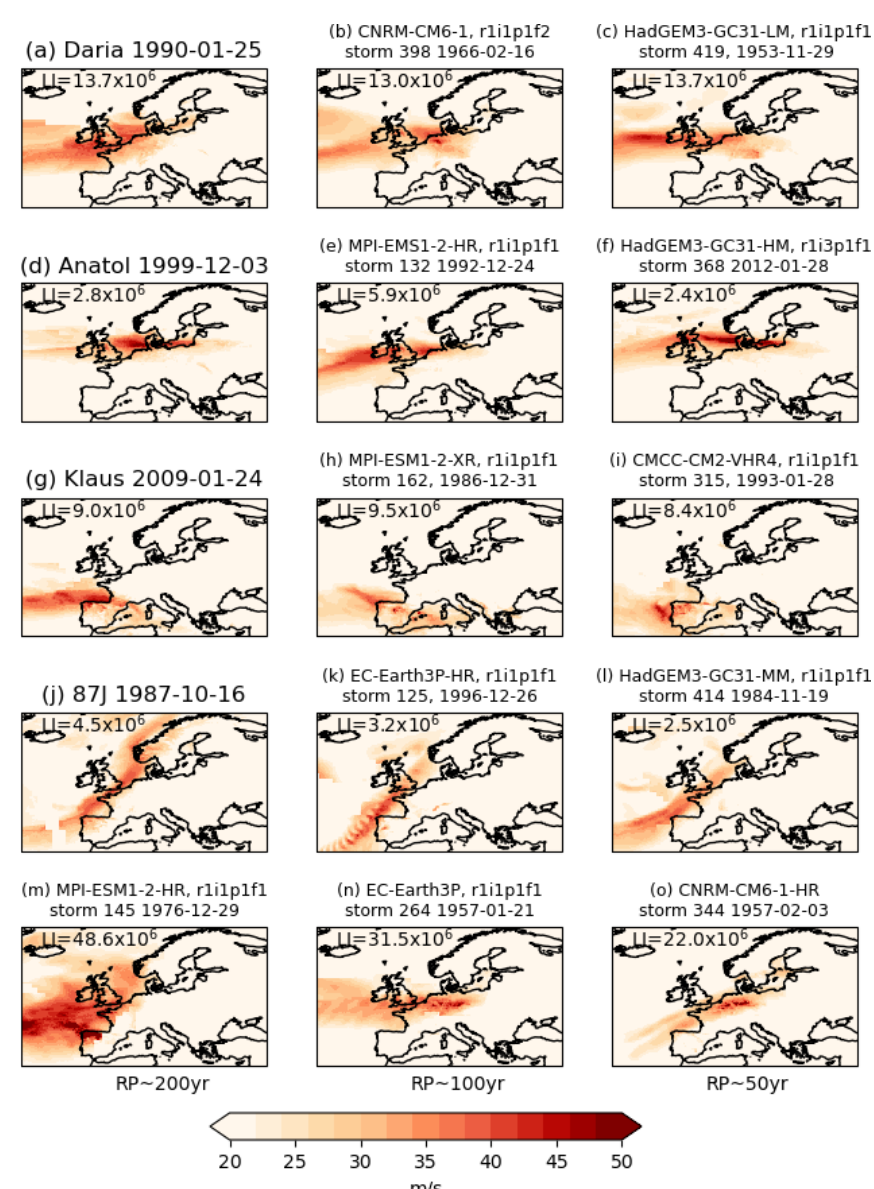
Figure 5. Example of observed and simulated footprints: left column panels (a,d,g,j) are re-analysis footprints of the famous storms Daria, Anatol, Klaus and 87J (the Great Storm of 1987). The footprints in the middle and right columns are from PRIMAVERA models, with each row showing two examples of storms of a similar type to the re-analysis examples. The central date of each footprint is given in the panel titles. The bottom row (m–o) shows the footprints for events with return periods of approximately 200, 100 and 50